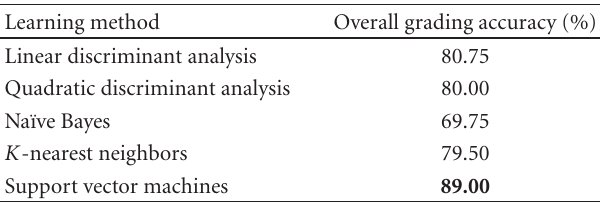
Table 1: Overall grading accuracies for the supervised machine learning techniques used in our analysis. SVM classifiers clearly achieve significantly higher grading accuracy than the other meth- ods. The data set includes 400 acinar